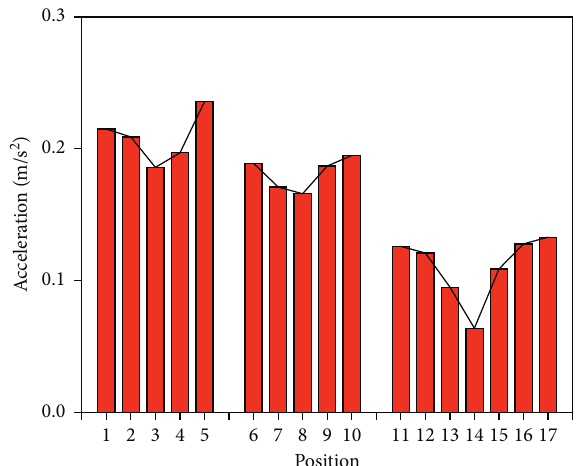
Figure 20: The total effective value of vibration acceleration at different measurement points of the iron